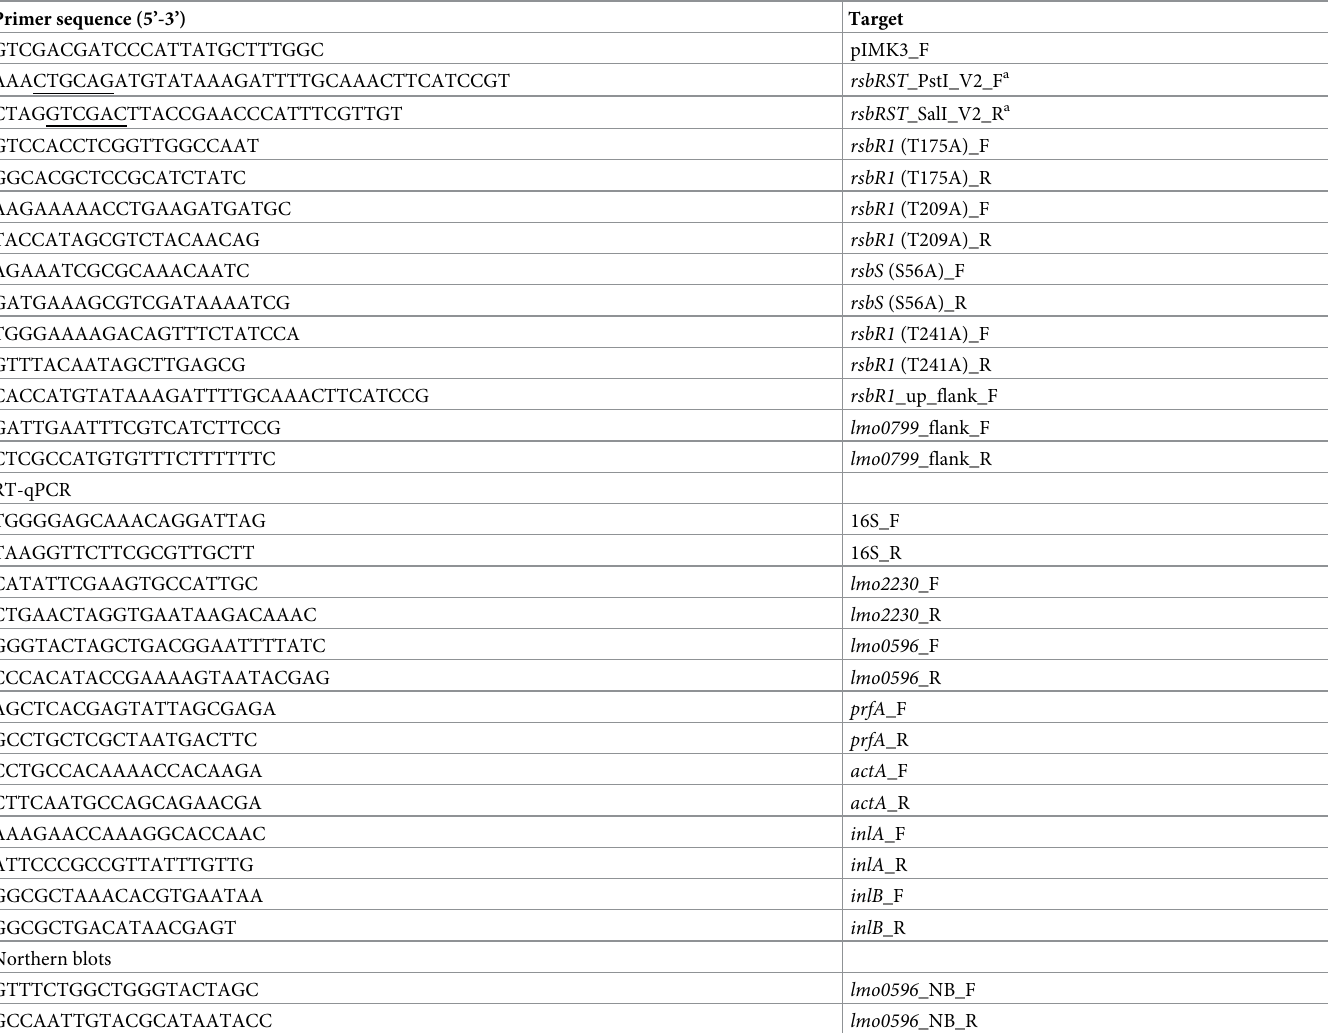
Table 2. Primers used in this study. Primer sequence